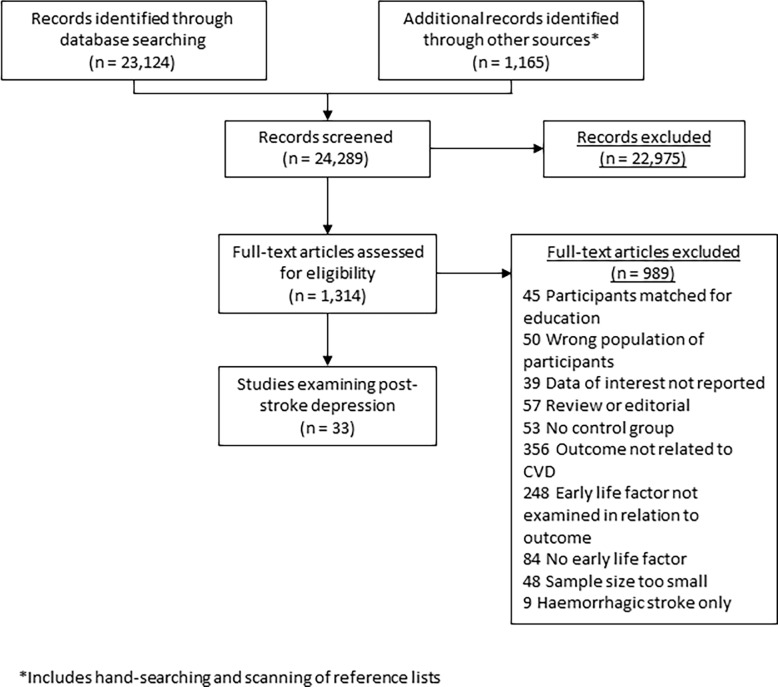
PRISMA flow chart of search process.